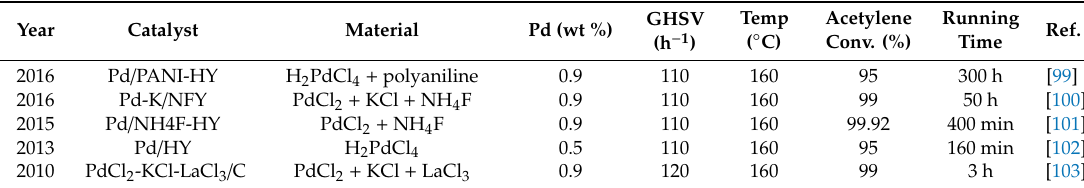
Table 4. Performance of Pd catalysts for acetylene hydrochlorination.